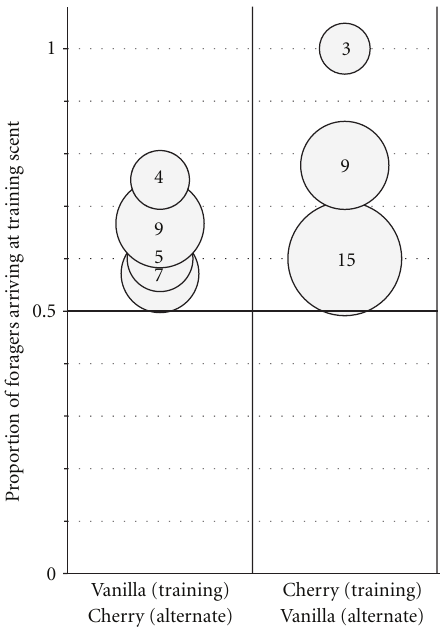
Figure 2: Arrivals at the testing station. Training and alternate scents are indicated. Each circle represents one colony. The center of the circle indicates the proportion arriving at the training scented dish for the colony. The area of the circle is proportional to the total numbers of unmarked foragers arriving at either of the dishes at the testing station; this number is indicated by the number inside the